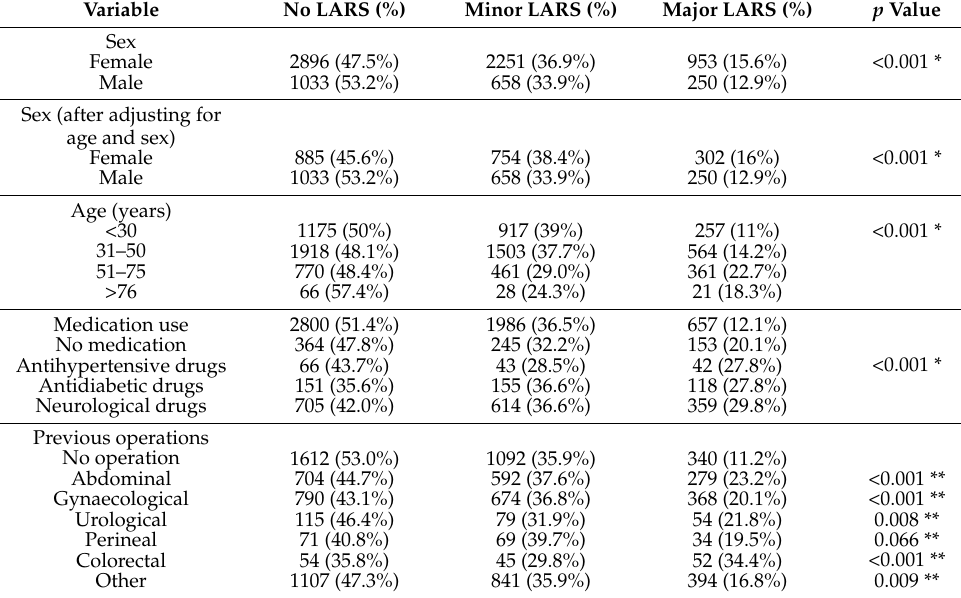
Table 2. Low Anterior Resection Syndrome score (LARS) score correlation to various factors.